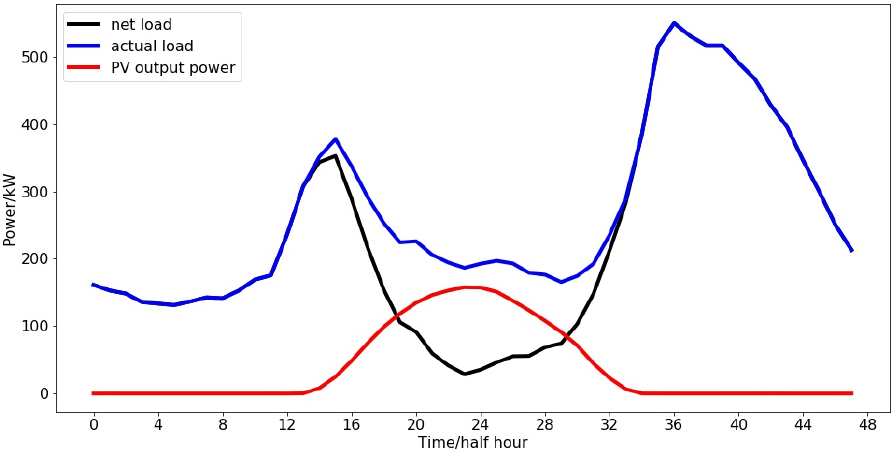
Figure 1. Example of the composition of net load.